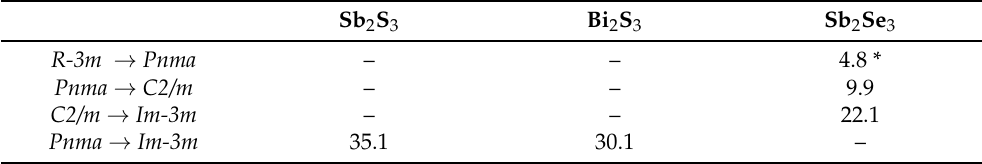
Table 1. Theoretical estimation of the pressure-induced phase transitions of R-3m → Pnma , Pnma → disordered C2/m , C2/m → disordered Im-3m , and Pnma → disordered Im-3m for the Sb 2 Se 3 , Sb 2 S 3 , and Bi 2 S 3 compounds (presented in units of